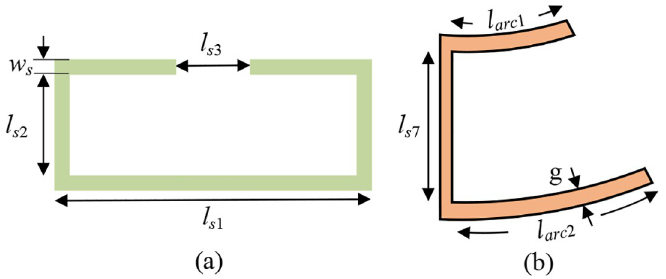
Fig 12. Notch structure diagram. (a) SRR. (b)